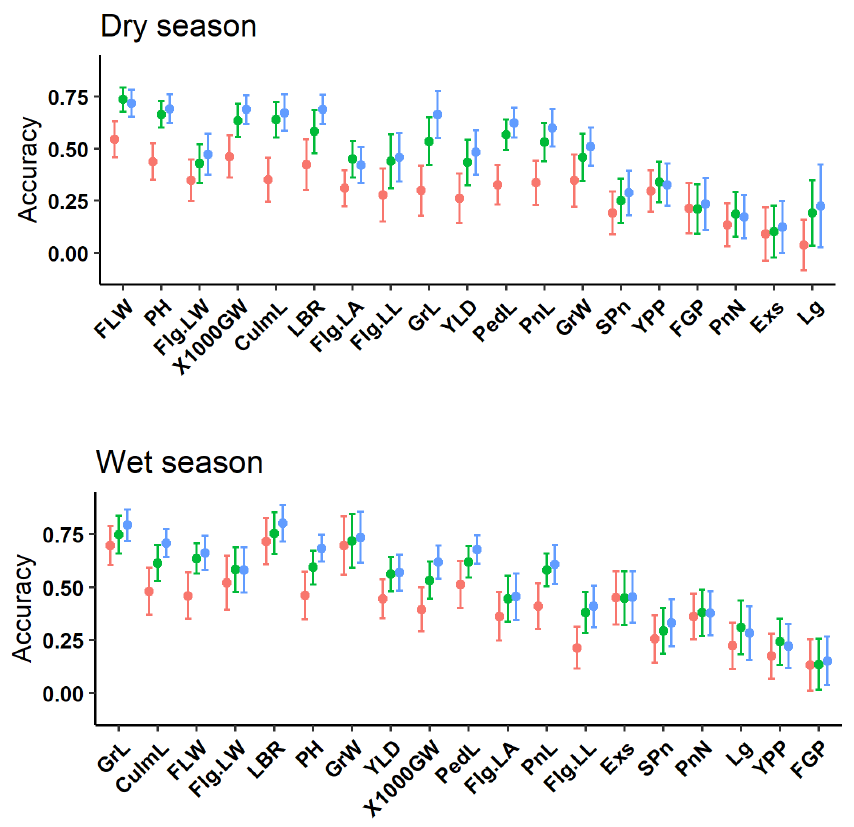
Figure 2. The predictive accuracy of three genomic prediction models for DS and WS (sorted by the narrow-sense heritability). The labels of x -axis denote 19 traits’ names. The y -axis represents the predictive accuracy for three models. Each point represents the mean prediction accuracy of 100 times (n = 5 × 20 times). The error bar indicates the standard deviation of prediction accuracy. The dot color of red, green, and blue represent GBLUP, GFBLUP, and mtGBLUP model, respectively.